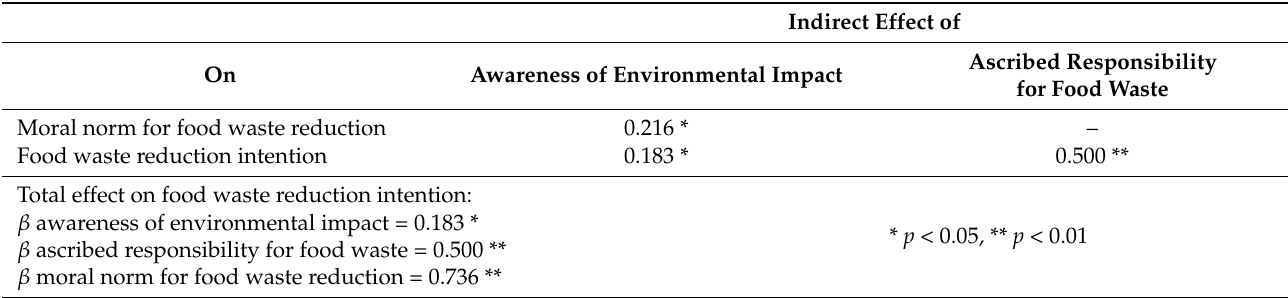
Table 4. Results of the indirect and total effect